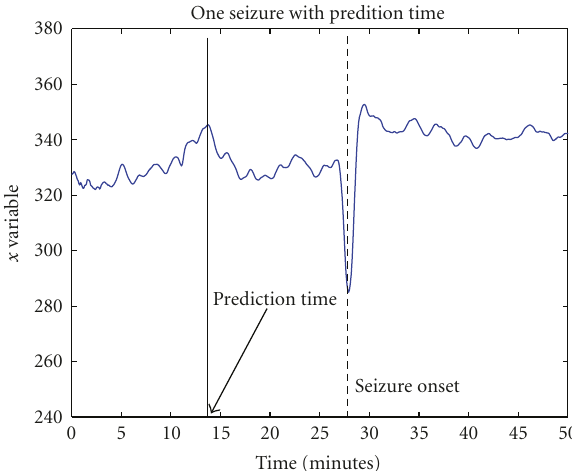
Figure 1: One typical figure with prediction time and seizure. The vertical solid line marks prediction time point and the vertical dashed line indicates seizure